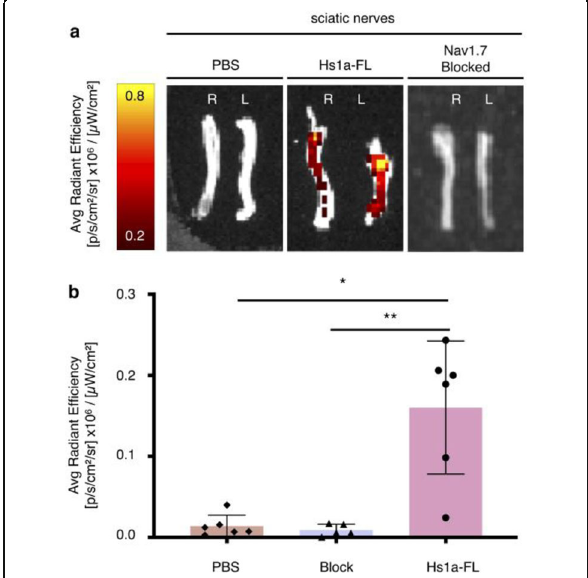
Fig. 4 Epifluorescence imaging of fresh, unprocessed mouse sciatic nerves with Hs1a-FL. a Epifluorescence images of resected sciatic nerves from animals injected with PBS, Hs1a-FL (4 nmol, 45 μ M of Hs1a-FL in 100 μ L of PBS), and a Hs1a/Hs1a-FL mixture (Hs1a-FL, 45 μ M, 4 nmol and Hs1a 120 μ M, 12 nmol in 100 μ L PBS). Images were taken 30 min after tail vein injection. b Fluorescence intensity quantification. Unpaired t test. * p value < 0.05; ** p value <